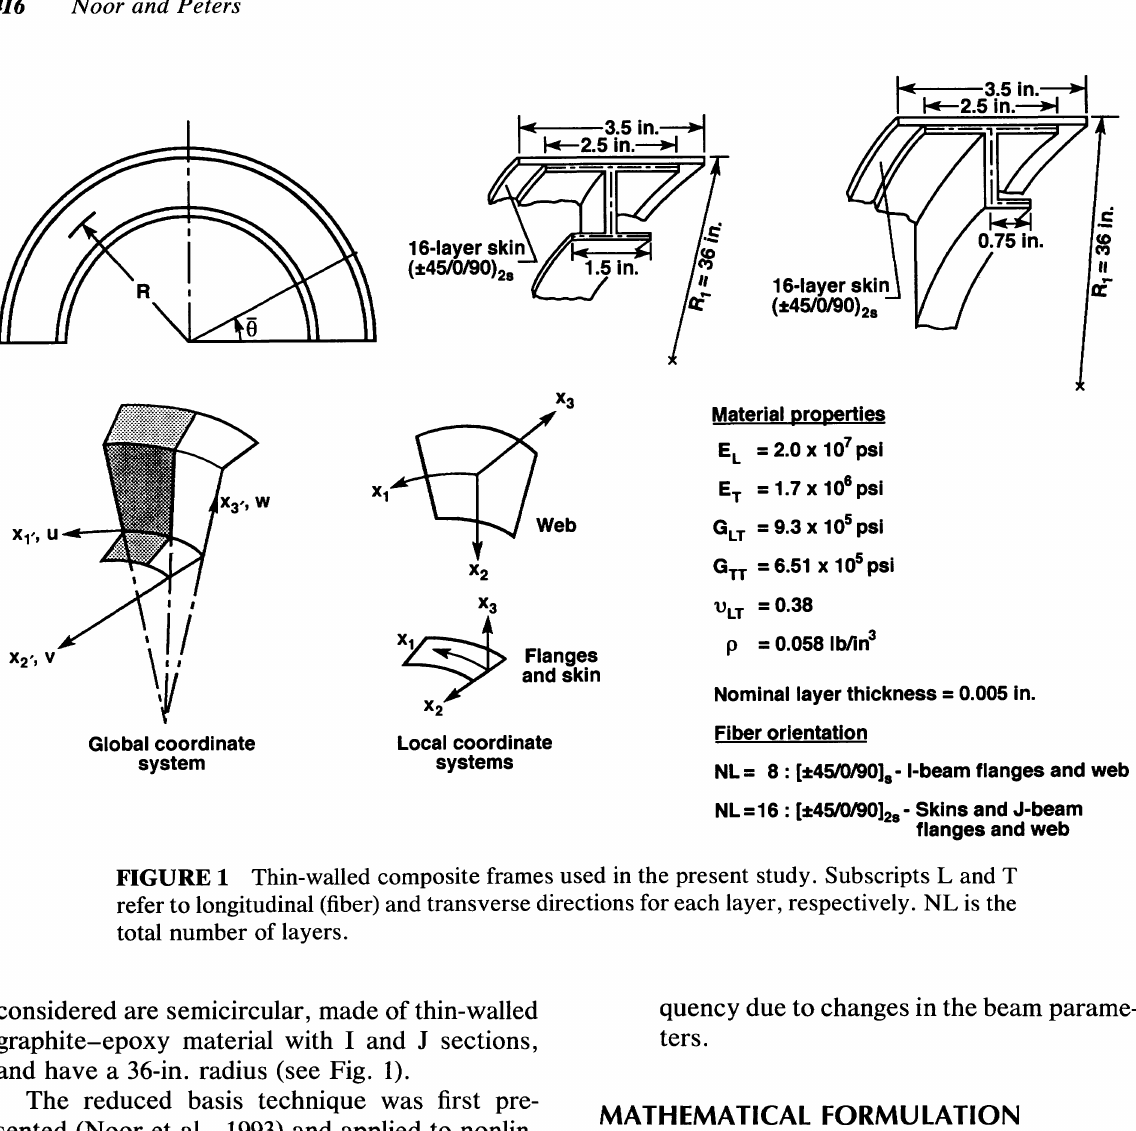
FIGURE 1 Thin-walled composite frames used in the present study. Subscripts Land T refer to longitudinal (fiber) and transverse directions for each layer, respectively. NL is the total number of